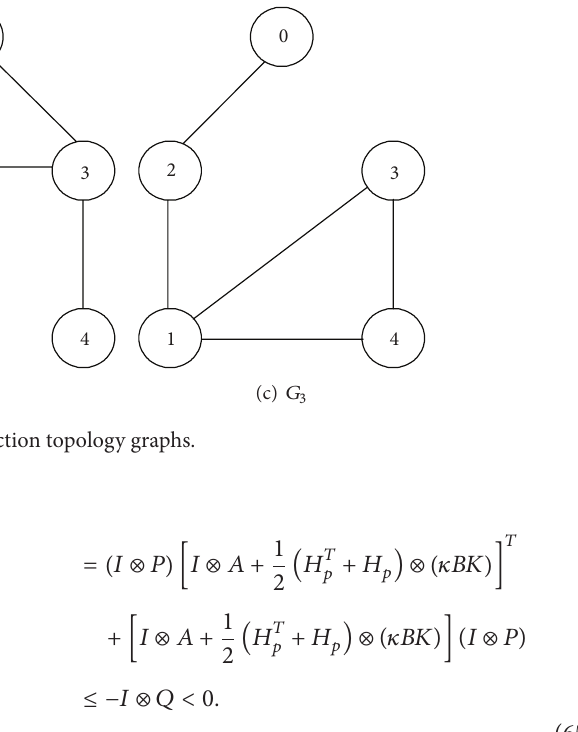
(𝑗) (𝑡) and V (𝑡) − 𝑇𝜛(𝑡) of four agents. 𝑖 𝑖